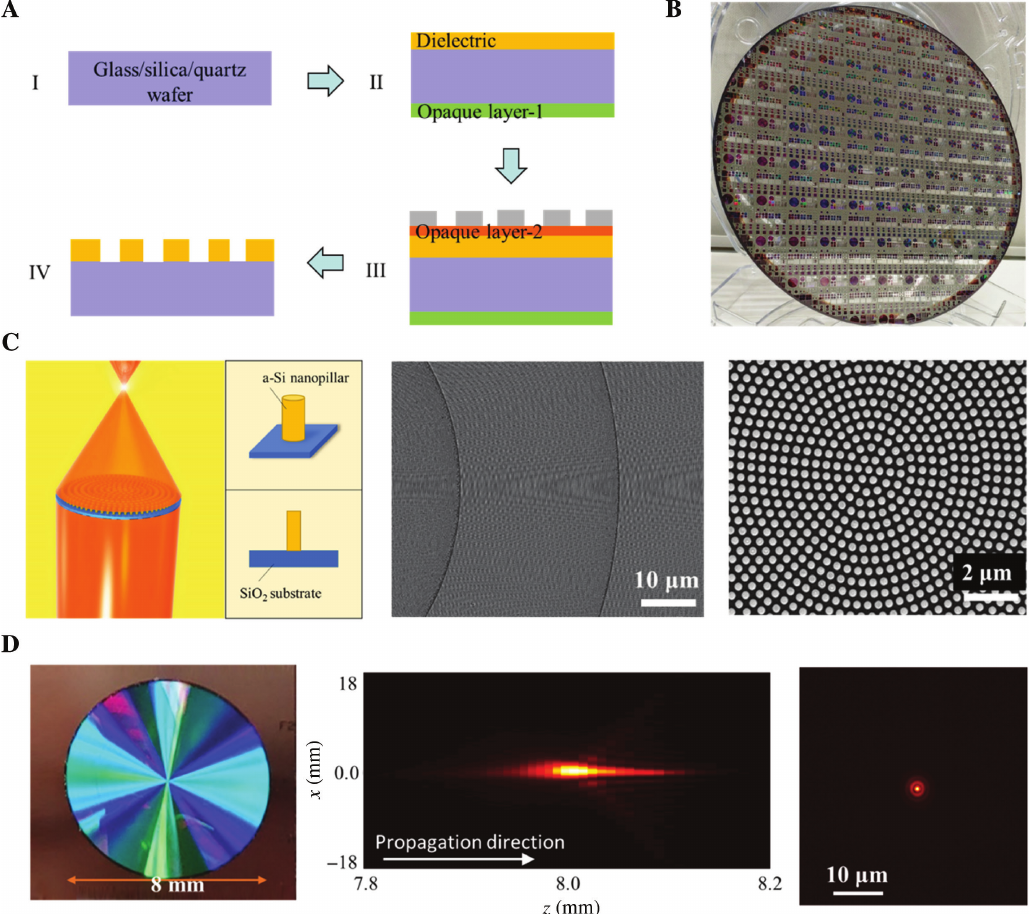
Figure 7: Metasurface-based devices demonstrated through direct patterning on 12-inch glass wafer. (A) Fabrication process flow for direct patterning on glass wafer. (B) Fabricated 12-inch glass wafer. (C) Schematic of large-area metalens on glass substrate (left) and top-view (middle) and zoomed-in view (right) SEM images of the nanopillars with a height of 400 nm designed for metalens. (D) Fabricated 8-mm-diameter metalens on glass wafer (left); optical intensity distribution along the propagation direction after metalens, showing focusing effect (middle); and intensity distribution at the focal plane, showing spot size of 1.5 μ m (right). (B–D) Adapted with permission from [74]. © The Optical